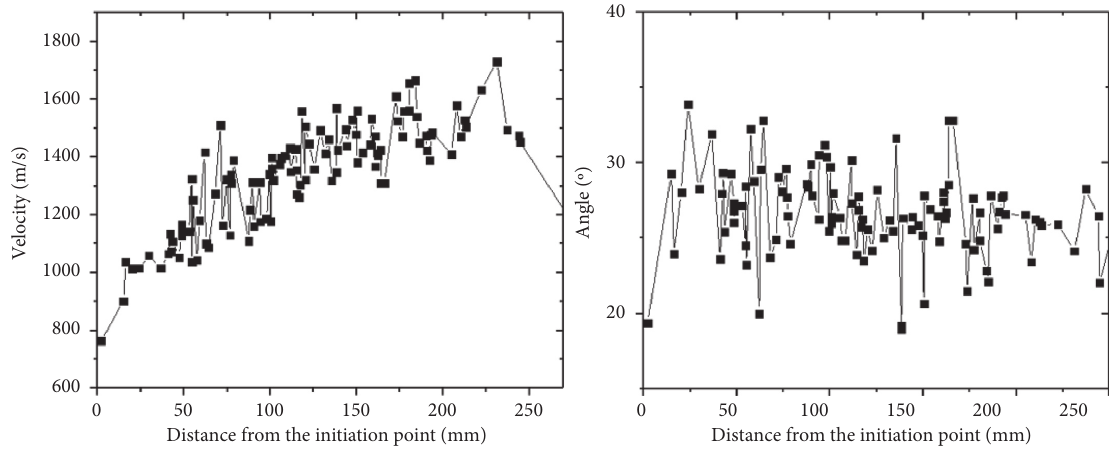
Figure 6: Dynamic fragment axial distribution.